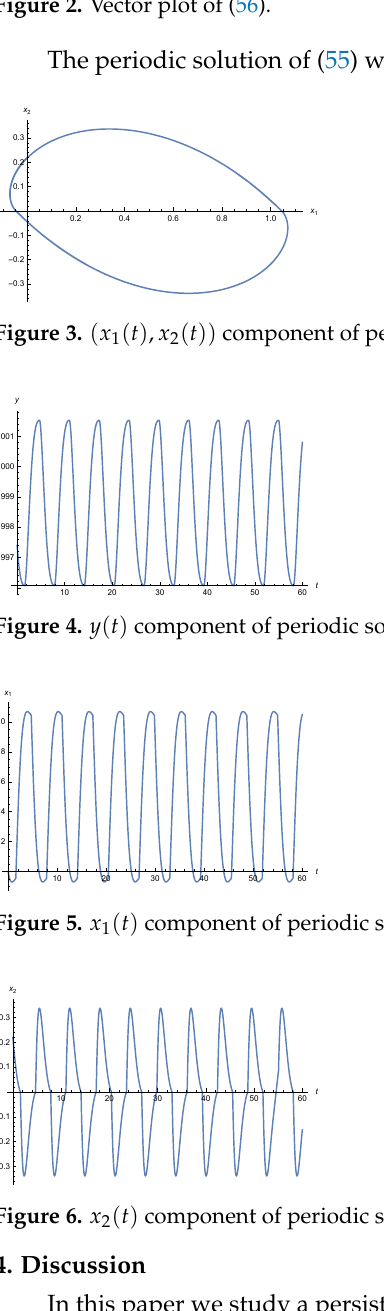
Figure 2. Vector plot of (56).